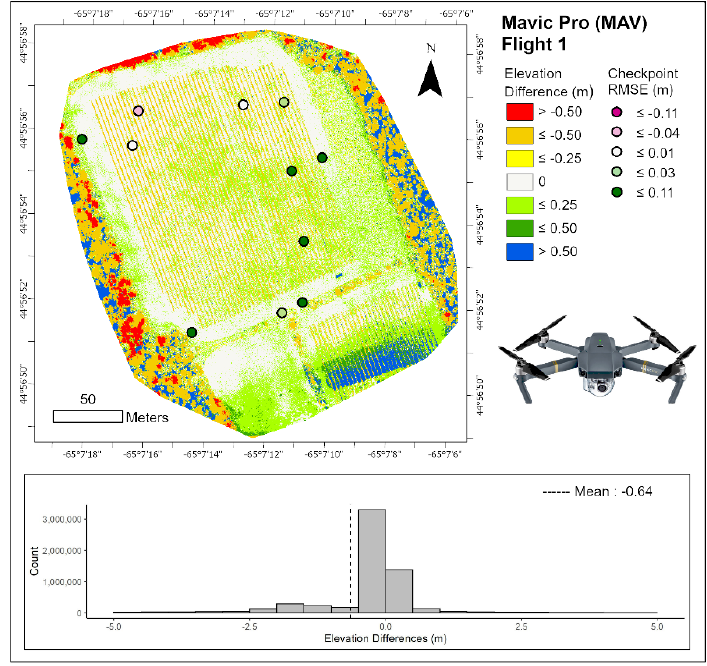
Figure 6. DSM of Difference (DoD) between the Mavic Pro (MAV) (flight 1) and the LiDAR DSM. The Figure 6. DSM of Di ff erence (DoD) between the Mavic Pro (MAV) (flight 1) and the LiDAR DSM. dashed line represents the mean error of − 0.64 m. The dashed line represents the mean error of − 0.64 m. Remote Sens. 2020 , 12 , x FOR PEER REVIEW